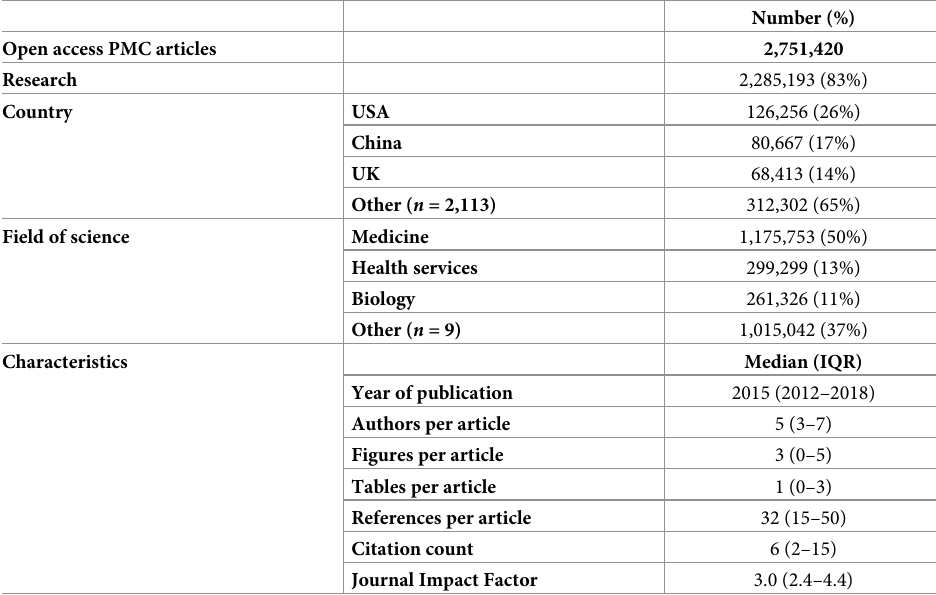
Table 2. Metadata across all 2,751,420 open access publications on PubMed Central